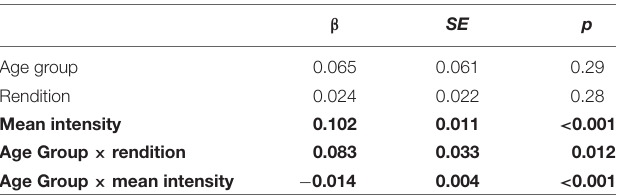
TABLE 3 | Fixed effect estimates of the best-fitting models of performance for the group comparison of the arousal data; bold indicates significant results, number of observations = 1776, AIC = 1496.